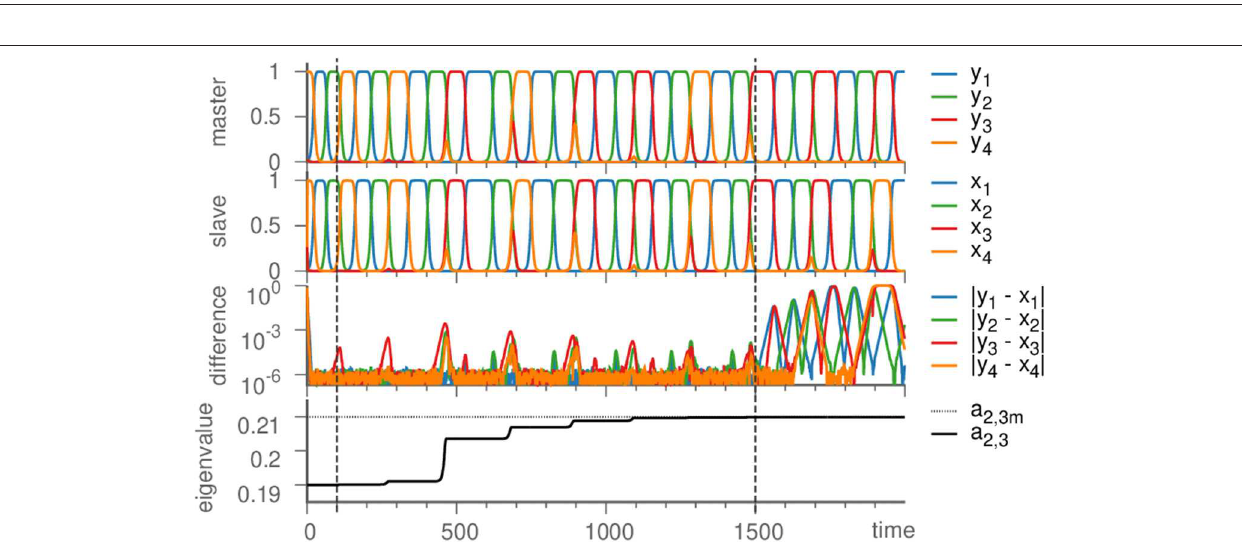
FIGURE 2 | Learning dynamics near the Kirk-Silber network. From top to bottom: Dynamics of the master system, the slave system, their difference, and the eigenvalue a 2,3 are plotted against time. Vertical dashed lines mark the beginning of learning ( t ϑ turned off ( 0), so that due to different noise realizations the system states slowly diverge. Parameters are ϑ → = chosen as a rad. 1, a contr. 0.22, a exp. 0.2, and a 2,3 m = − = − = =